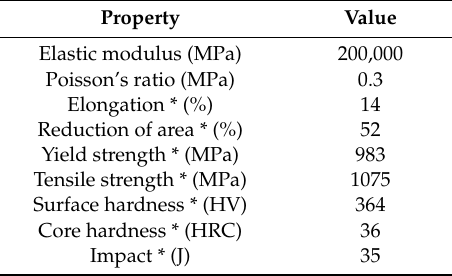
Table 3. Measured material properties of M42 bolt.